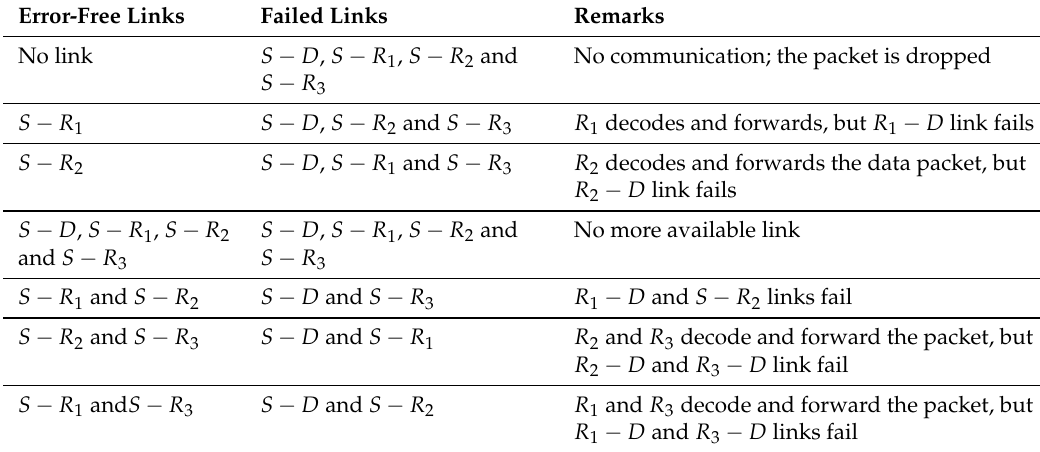
Table 2. Conditions for the failure of the three-stage relaying